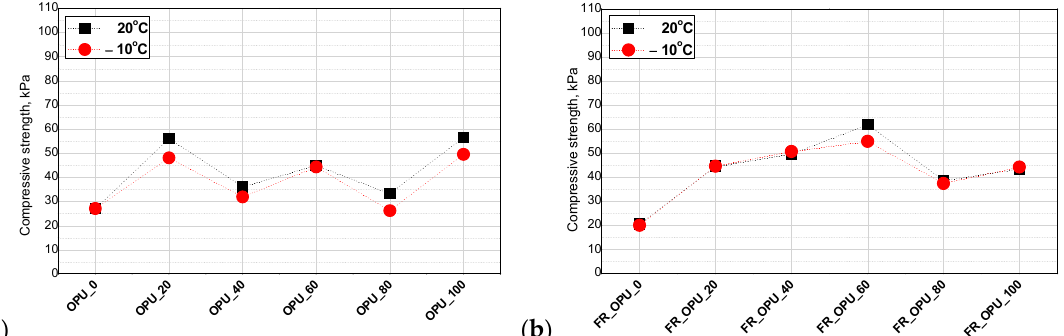
Figure 5. Normalized compression strength of PUR foams modified with bio-polyol ( a ) and bio-polyol and flame retardant ( b ).